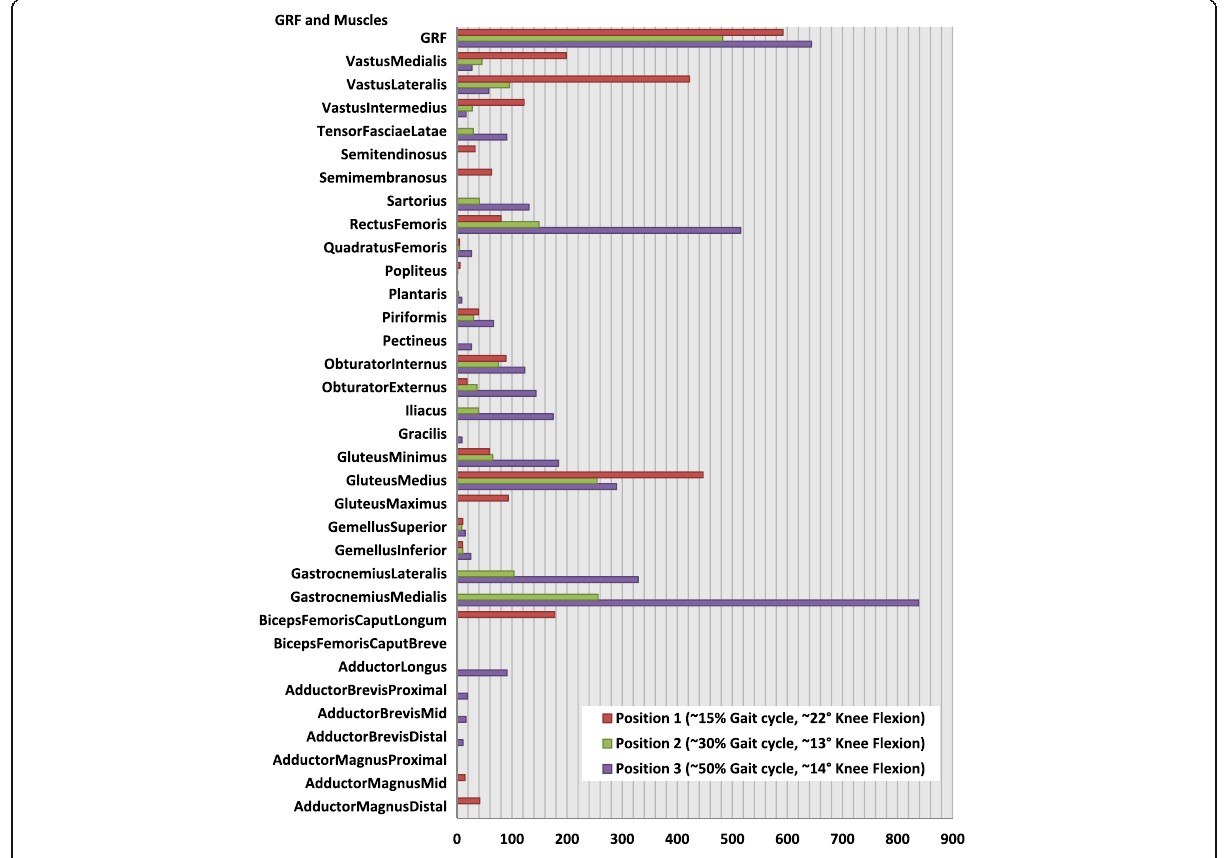
Fig. 4 Magnitudes of the muscle forces at the three selected positions: The set of the active muscles is different from one position to another